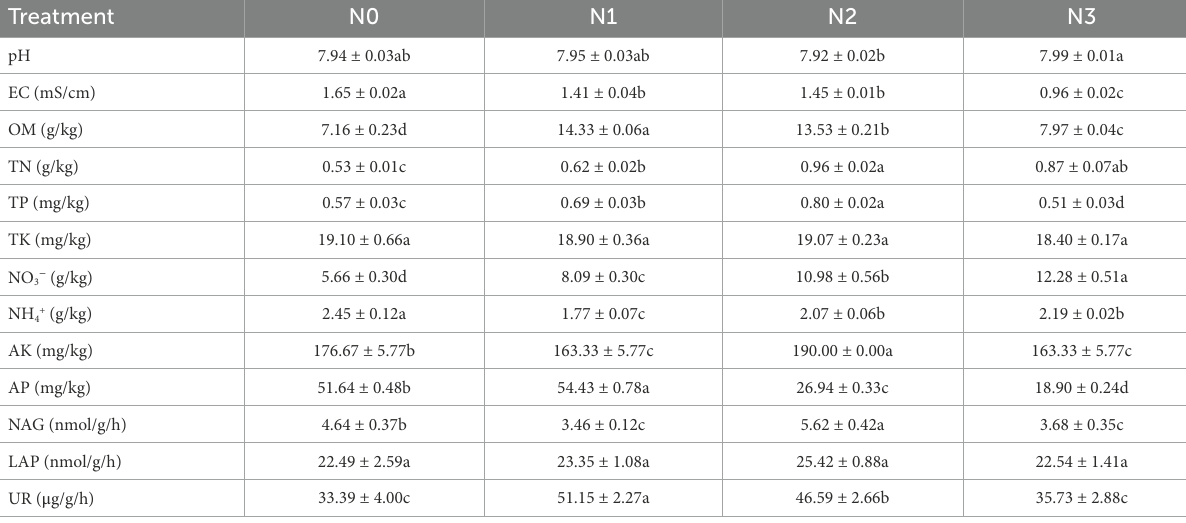
TABLE 1 Response of soil chemical properties and soil enzyme activity to experimental N addition.